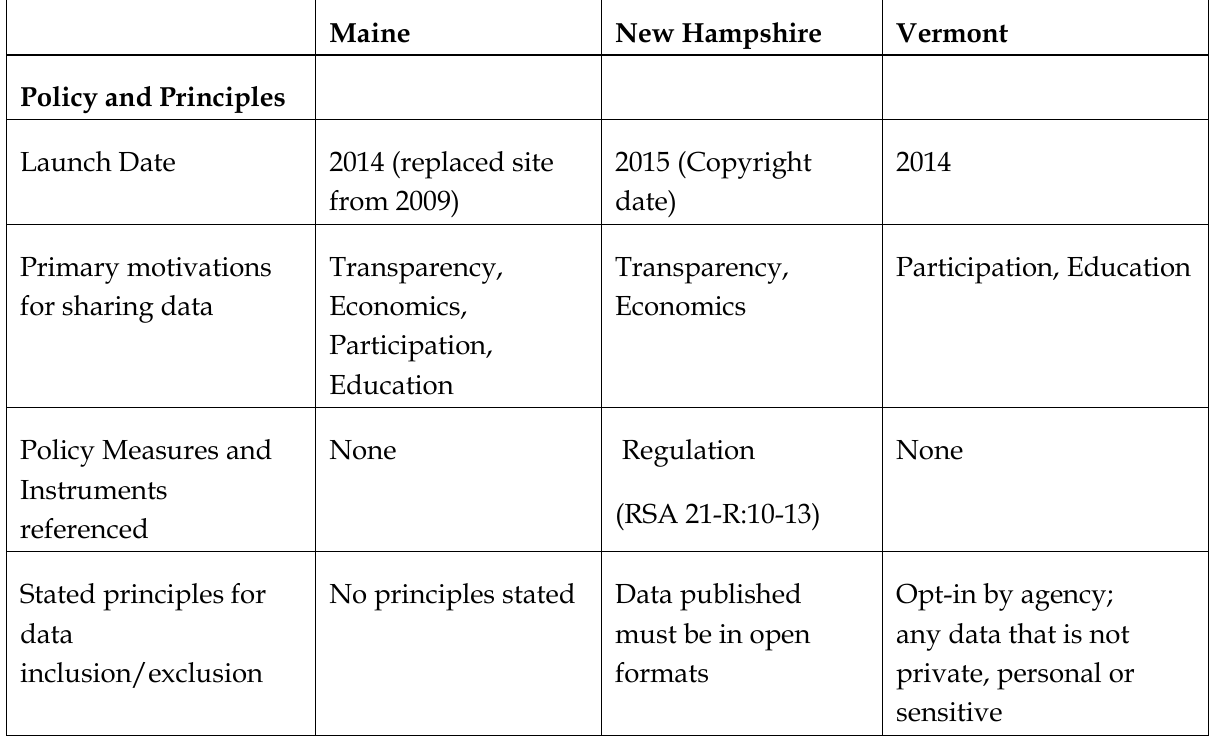
Table 1: Summary of comparative analysis of state